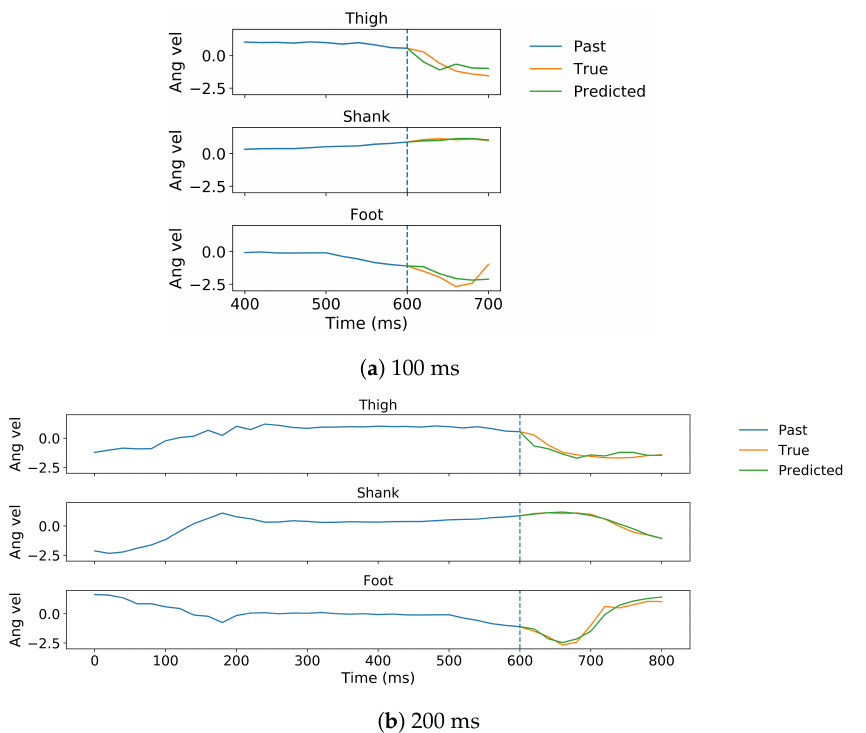
Figure 9. The 100 ms ( a ) and 200 ms ( b ) ahead predictions for z-score normalized angular velocities of ipsilateral thigh, shank and foot of one representative subject in the inter-subject implementation, shown for prediction from the same point in time. All angular velocity values shown are normalized to have zero mean and unit variance. The predicted trajectory is shown in green and the true in orange. Note that more past data are used for the 200 ms ahead prediction than for the 100 ms ahead prediction.